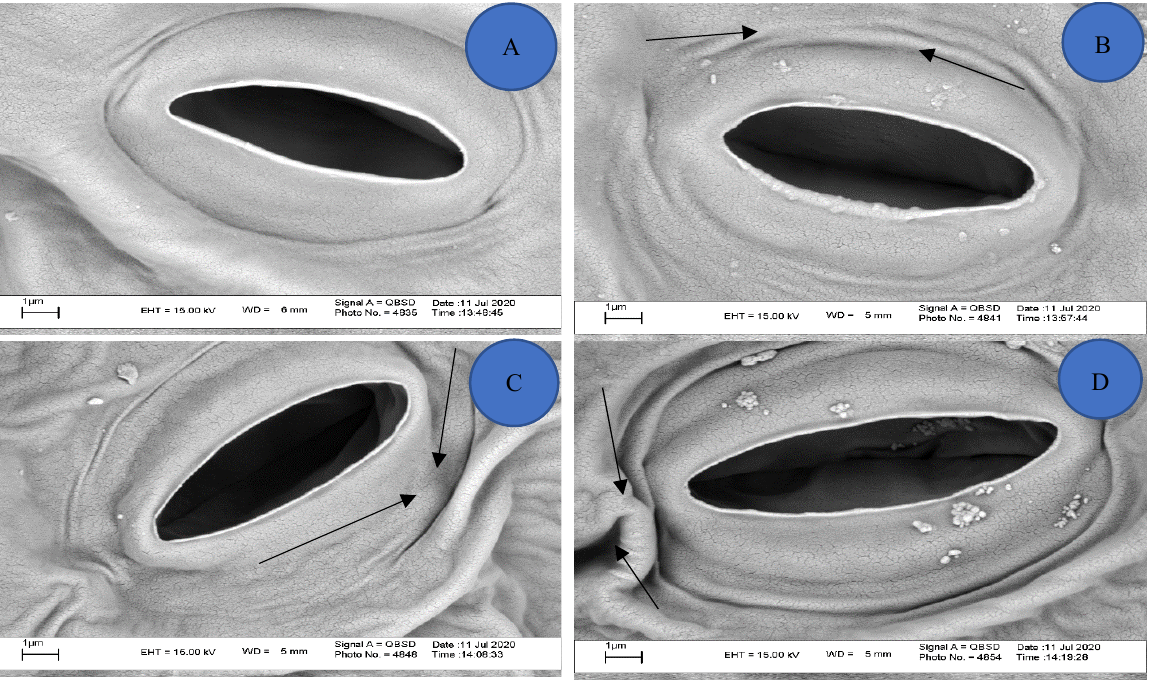
Figure 9. Effect of DCD on lettuce leaf stomata. ( A ) Control, ( B ) concentration of 5 mg/kg DCD in